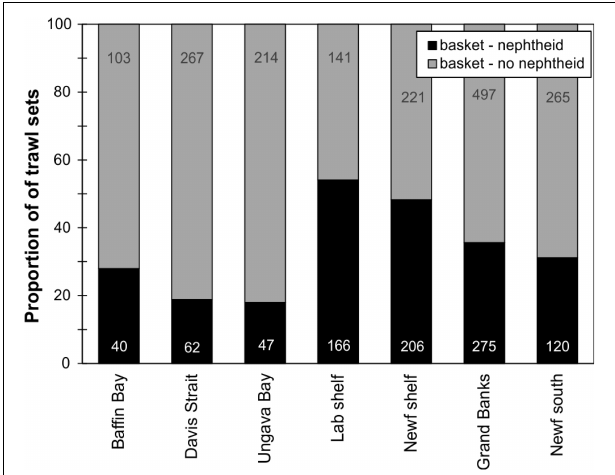
FIGURE 10 | Relative proportion of coral presence-absence in DFO RV trawl sets containing basket stars by region (number of trawl sets with/without corals relative to total number of sets per region – including basket star absences). Number of sets per region is shown.